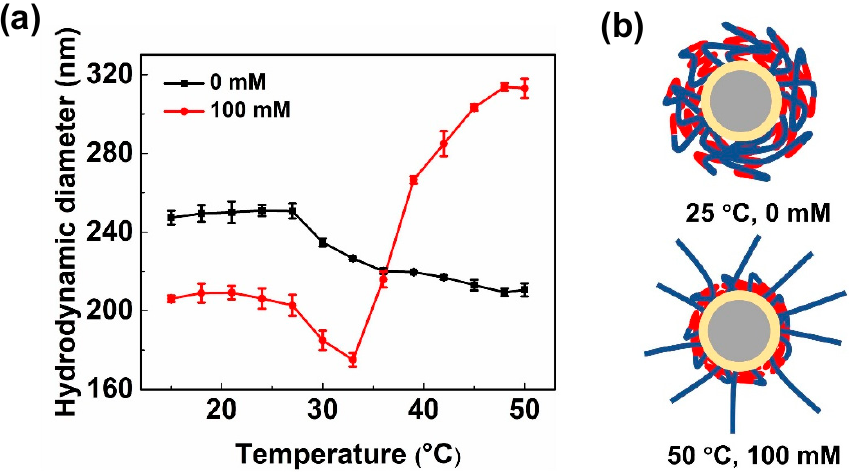
Figure 5. ( a ) Diameter with temperature at different ionic strength and ( b ) schematic illustration of